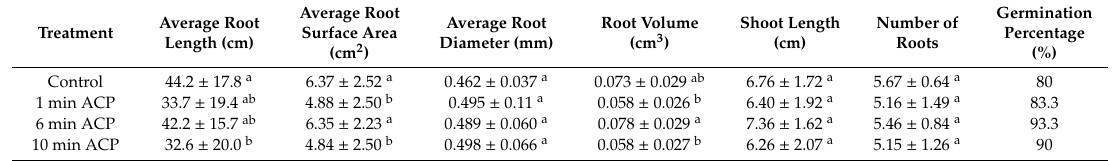
The values indicate the average of the germinated grains for each parameter. Values with different letters in the same column are significantly different ( p < 0.05, n = 3).